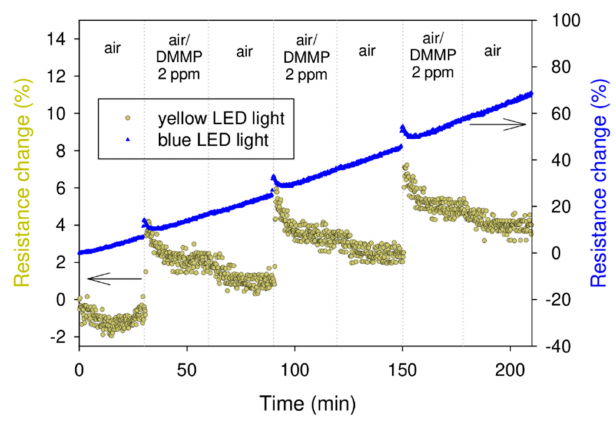
Figure 4. Electrical response of the RR-P3HT layer exposed to 2 ppm of DMMP under yellow and blue light illumination.